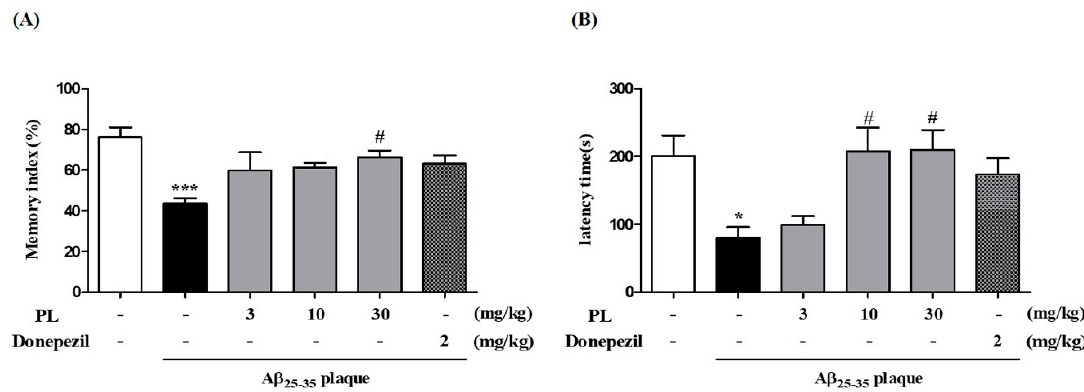
Figure 8. Effect of PL on memory impairment induced by A β 25–35 plaque in mice, as measured by ( A ) novel object recognition test (NORT) and ( B ) passive avoidance test (PAT) ( n = 7–8 per group). Values are mean ± standard error of the mean. * p < 0.01 and *** p < 0.001 vs. sham group; # p < 0.05 vs. A β 25–35 plaque group. Donepezil was used as a positive control.